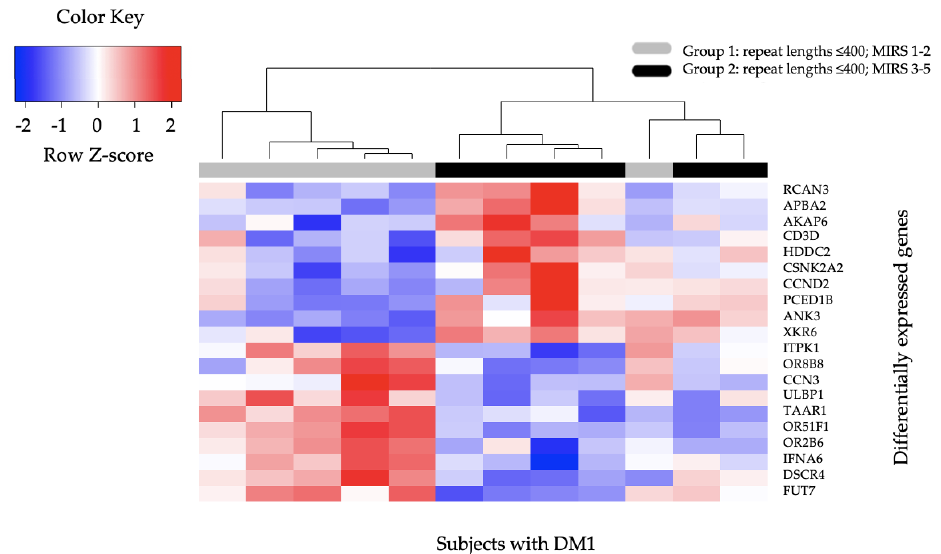
Figure 2. Hierarchical Clustering Heatmap of top 20 differentially expressed genes in DM1 DMBDI Group 1 and Group 2 patients. The heatmap presents the top 20 significant differentially expressed genes in subjects with DM1 from Group 2 (CTG repeat length ≤ 400, MIRS score 3–5) compared to Group 1 (CTG repeat length ≤ 400, MIRS score 1–2). Columns represent subjects with DM1, while rows represent specific genes of interest. The Z-score presents a measure of distance, in standard deviations, away from the mean. The color indicates the differentially expressed genes, with red indicating 10 higher expressed genes in Group 2 compared to Group 1 and with blue 10 lower expressed